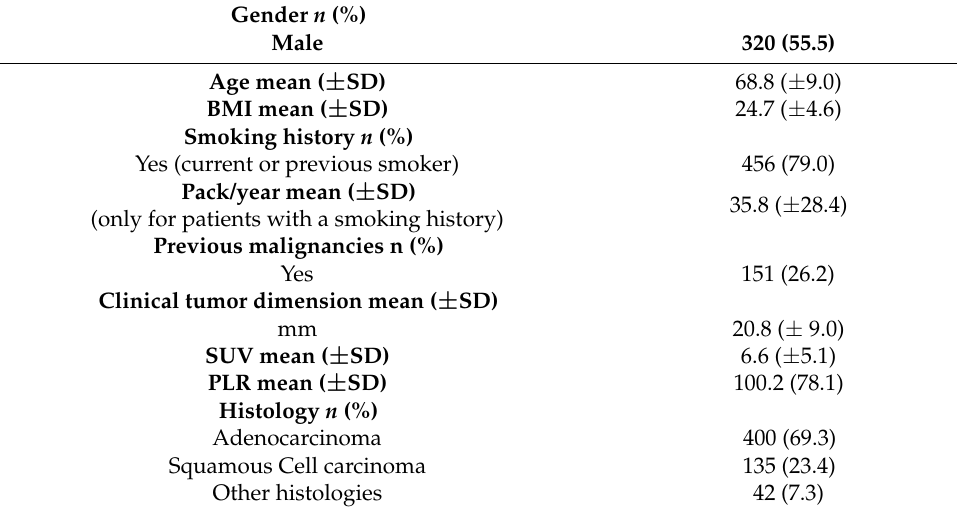
Table 1. Patient